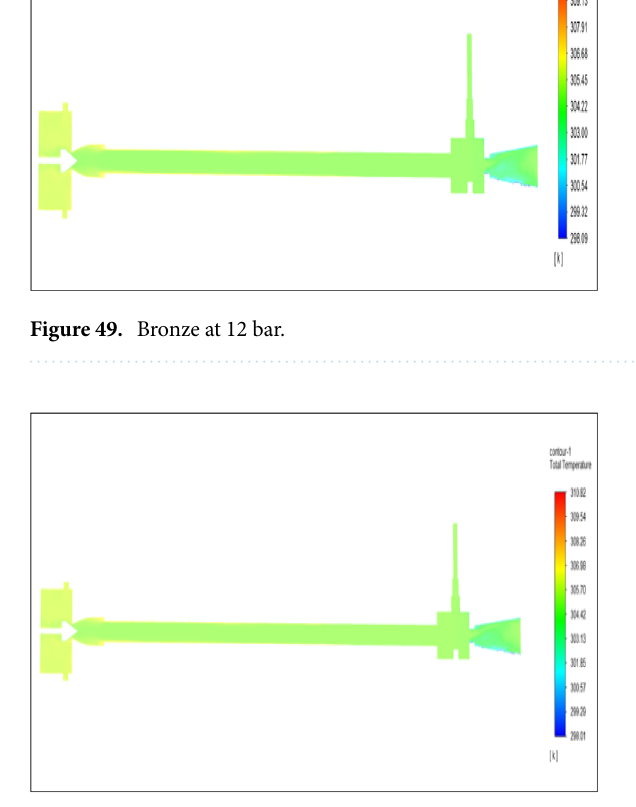
Figure 50. Copper at 12 bar.